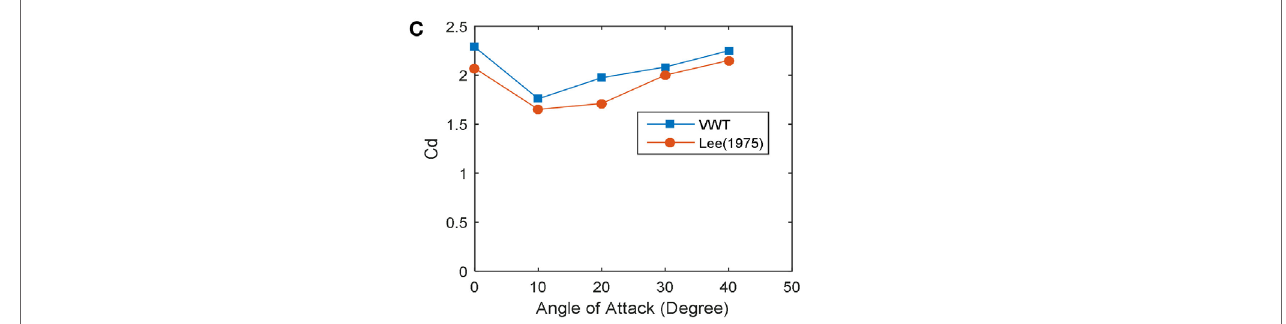
FigUre 12 | (a) Virtual Wind Tunnel login screen. (B) An example of a completed task. (c) Drag coefficient of a square cylinder at various angles of